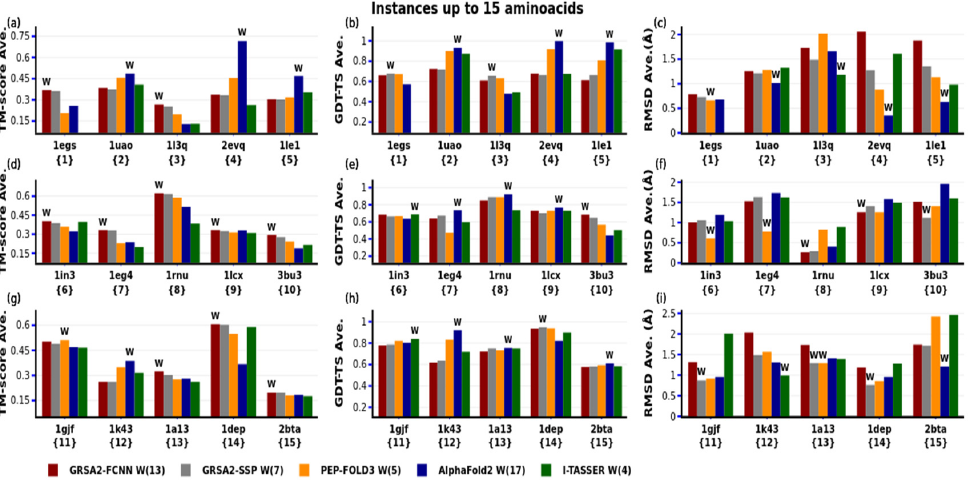
Figure 6. Comparison of GRSA2-FCNN versus I-TASSER, AlphaFold2, PEP-FOLD3, and GRSA2-SSP (Up to 15 aa): ( a , d , g ) present the average of the five best predictions of TM-score; ( b , e , h ) show GDT-TS for each instance; and ( c , f , i ) show the RMSD.